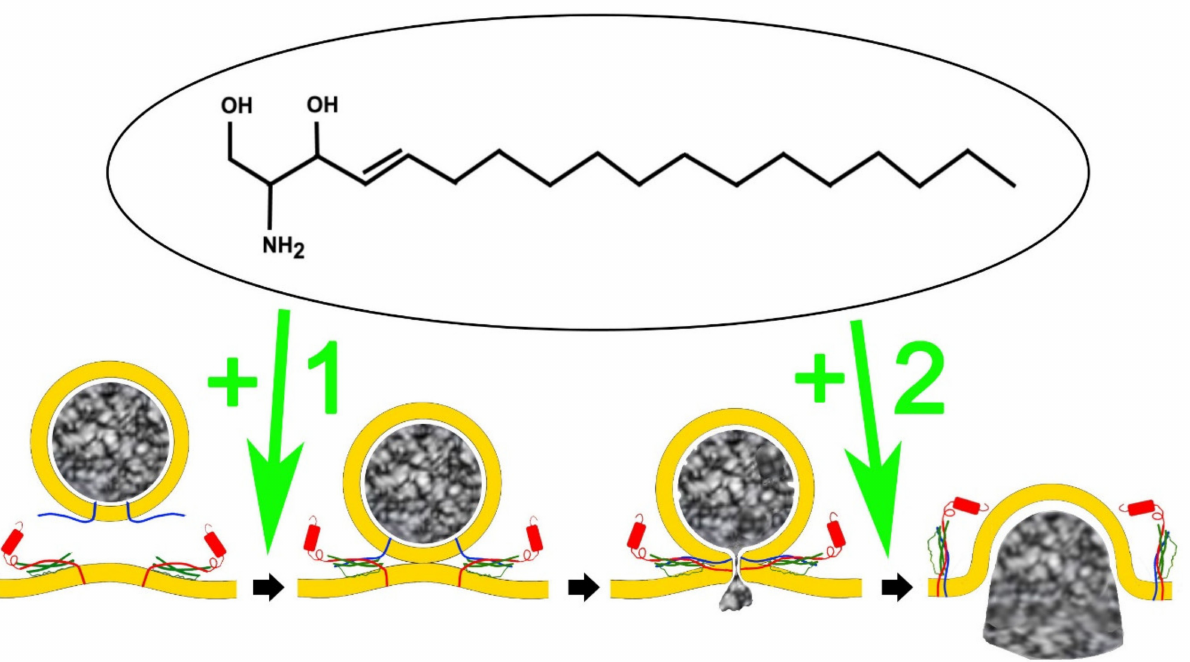
Figure 1. Sphingosine influences different steps of exocytosis. After the production of the signalling lipid sphingosine from sphingolipids, this modulates at least two phases of the exocytotic process, increasing the formation of the SNARE complex which enhance the frequency of vesicle fusions (1), and the transition from the “kiss and run” mode of fusion to the full collapse mode (2), causing an increase in the number of neurotransmitters released per event. Show here also the FTY720